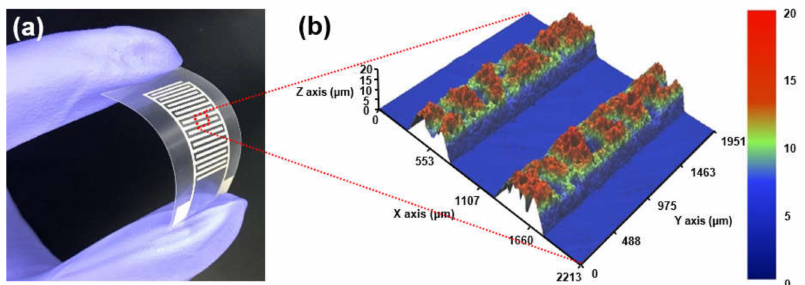
Figure 1. ( a ) Photograph and ( b ) 3D profile image of a flexible capacitive humidity sensor with Ag IDE on PET substrate.